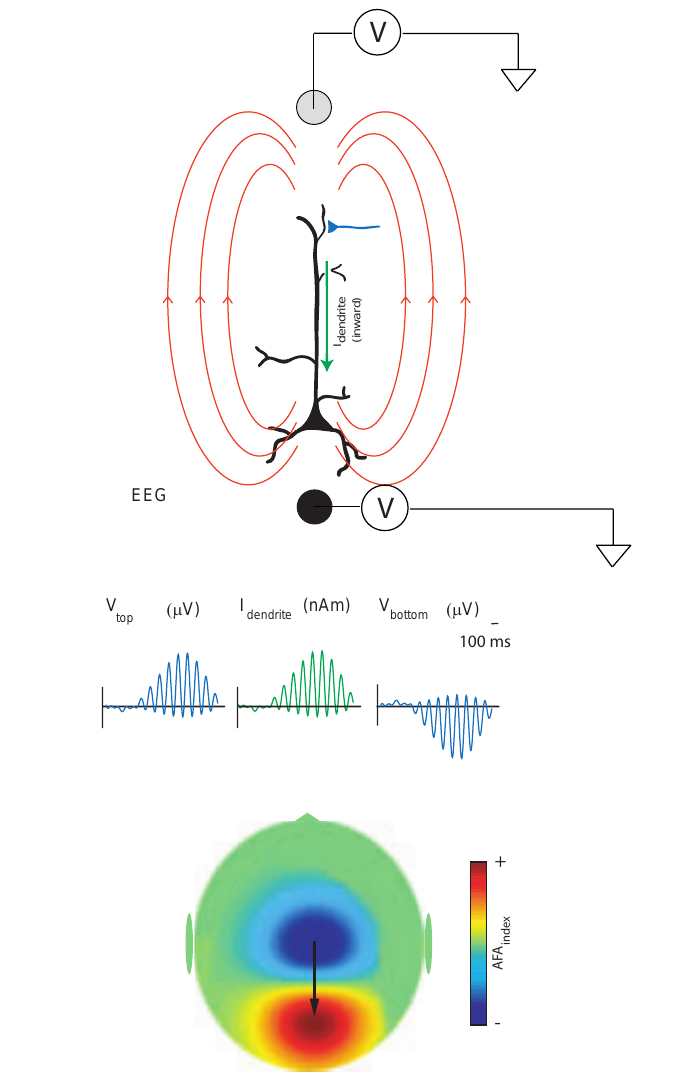
Figure 8 | (A) MEG signals measured outside the human scalp are primarily thought to be produced by magnetic fields induced by dendritic intracellular currents (I ) in pyramidal cells. EEG detects the differences in scalp potentials dendrite arising from the return currents. The polarity of the field will be determined by the direction (inward or outward) of the currents in the dendrites. (B) We propose